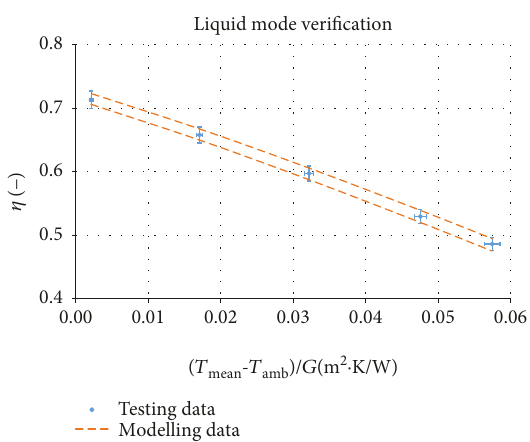
Figure 6: Mathematical model veri fi cation — liquid heating mode.